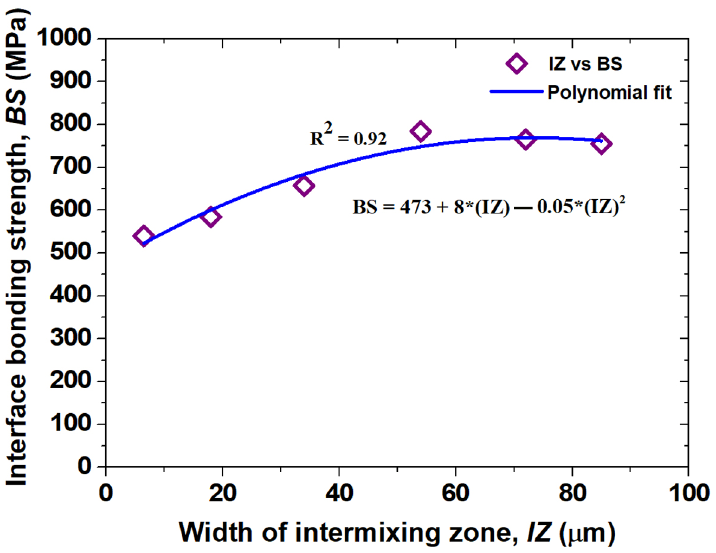
Figure 13. The relationship between width of intermixing zone and interface bonding strength.